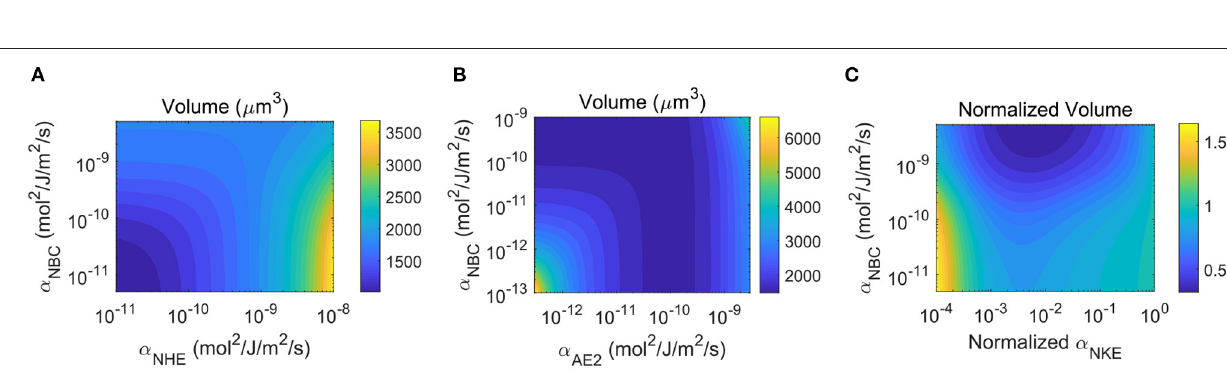
FIGURE 10 | Impact of the cell cortical mechanics on the responses of the cell under NHE inhibition as shown in Figure 2 . The data from E m = η m = 0 is the same as the data in Figure 2 . The reference cell volume is taken as r 0 = 7.5 µ m. (A) Cell volume for different cortical properties. (B) Total intracellular osmolarity for different cortical properties. (C) The passive cortical stress, σ p , for different cortical properties.